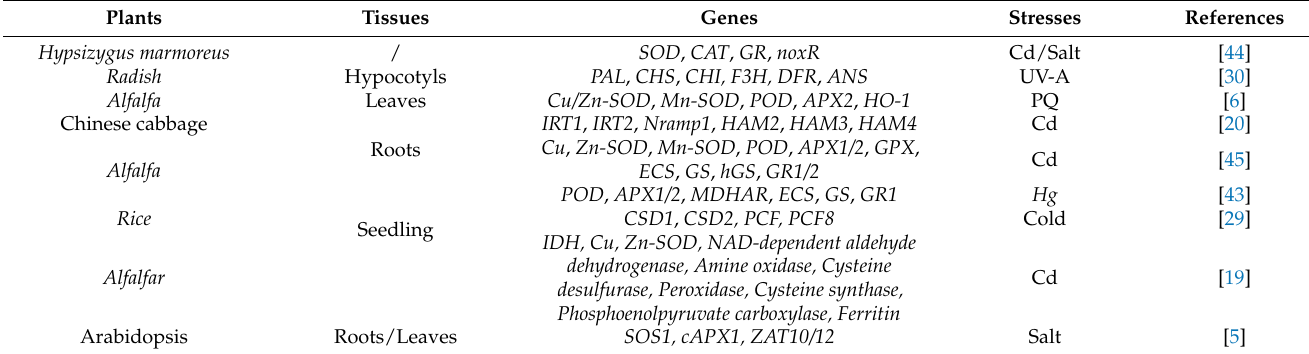
Table 2. Overview of H 2 -mediated genes under abiotic stresses in